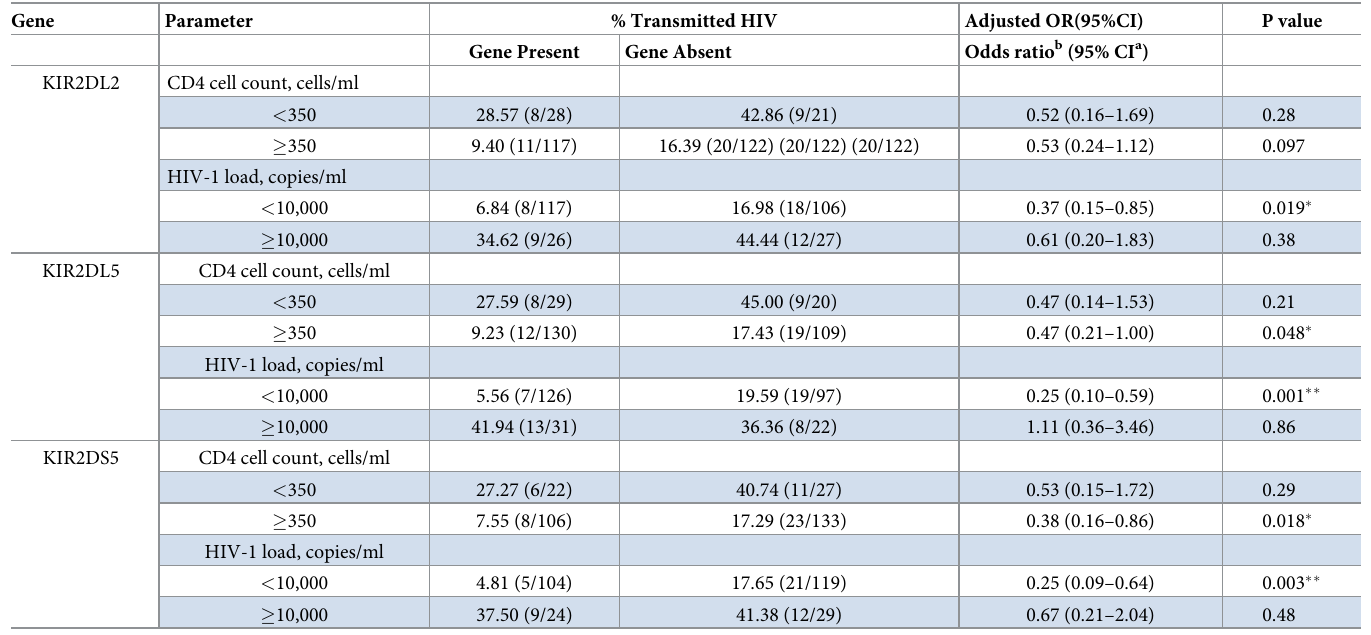
Table 5. Effect of CD4 cell count and HIV viral load on the relationship of maternal KIR2DL2, KIR2DL5, & KIR2DS5 with perinatal transmission of HIV-1. Gene